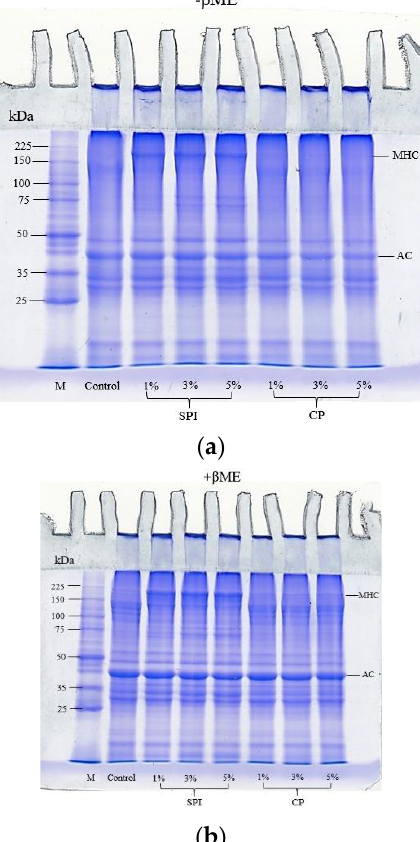
Figure 3. Effects of the addition of cricket powder (CP) and soy protein isolate (SPI) at different concentrations on protein patterns of mackerel surimi gels under non-reducing ( a ) and reducing conditions ( b ). MHC, myosin heavy chain; AC, actin; M, protein markers; β ME, β -mercaptoethanol (a reducing agent). Samples (15 μg protein) were loaded onto the polyacrylamide gel comprising a 10% running gel and a 4% stacking gel and subjected to electrophoresis at a constant current of 15 mA per gel.